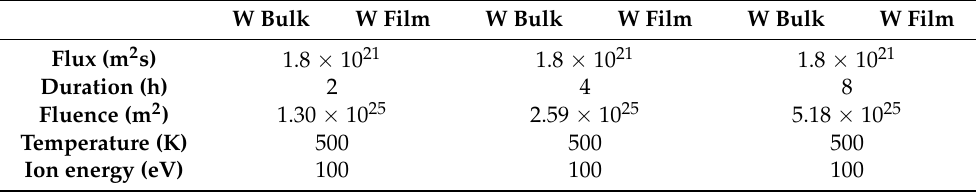
Table 1. Overview of the exposure conditions of the three investigated